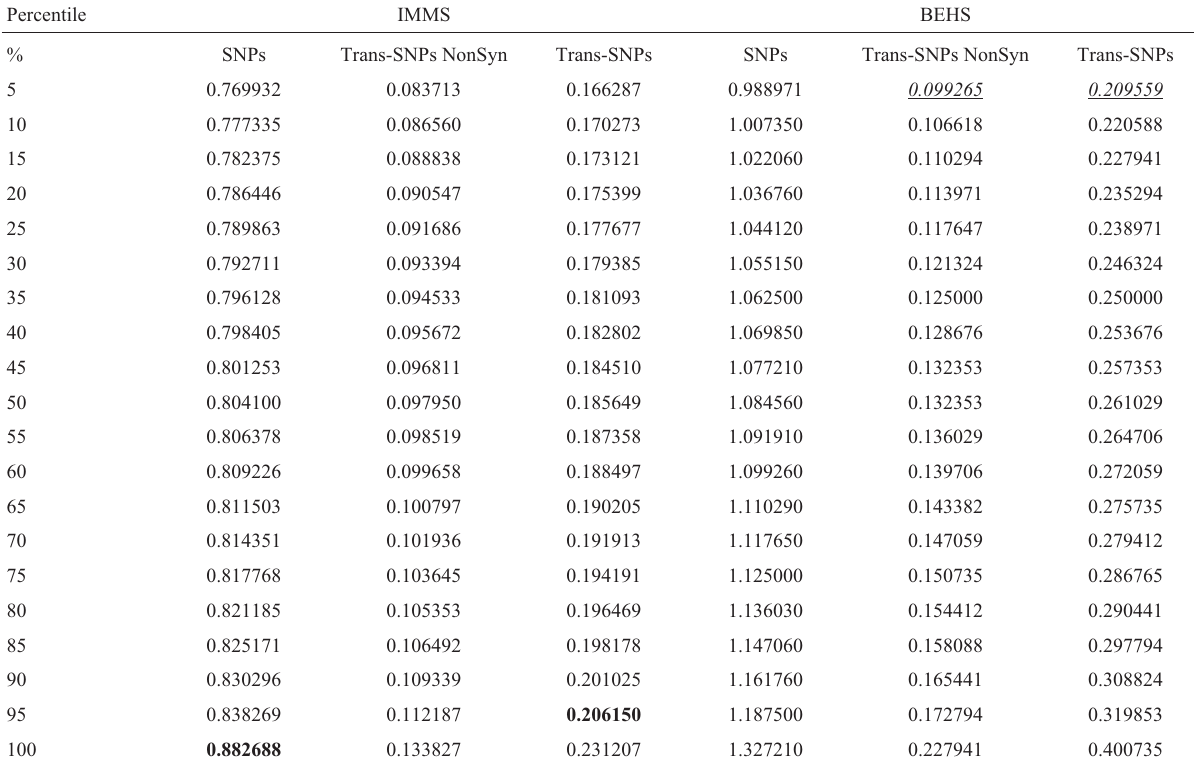
Table1 -Percentilesofthedistributionofthemeanvaluesofpolymorphismpergenein10000randomcombinationssimulatingeachoftheproposedtar- get gene systems (IMMS and BEHS) 1